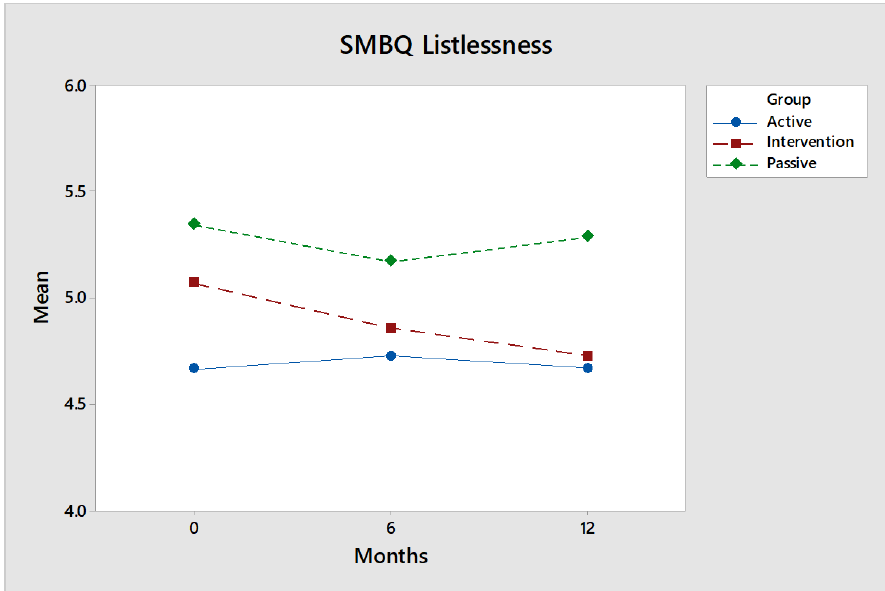
Figure 4. No statistical differences between the intervention group (red) and the control groups (green and blue). However, Shirom-Melamed Burnout Questionnaire (SMBQ) listlessness steadily decreased over time for the intervention group.